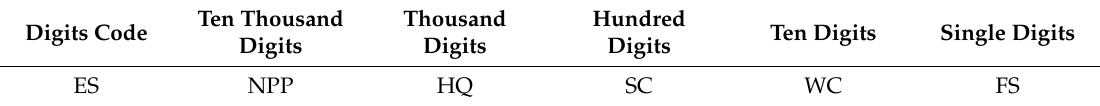
Table A1. Di ff erent digits codes for each ecosystem